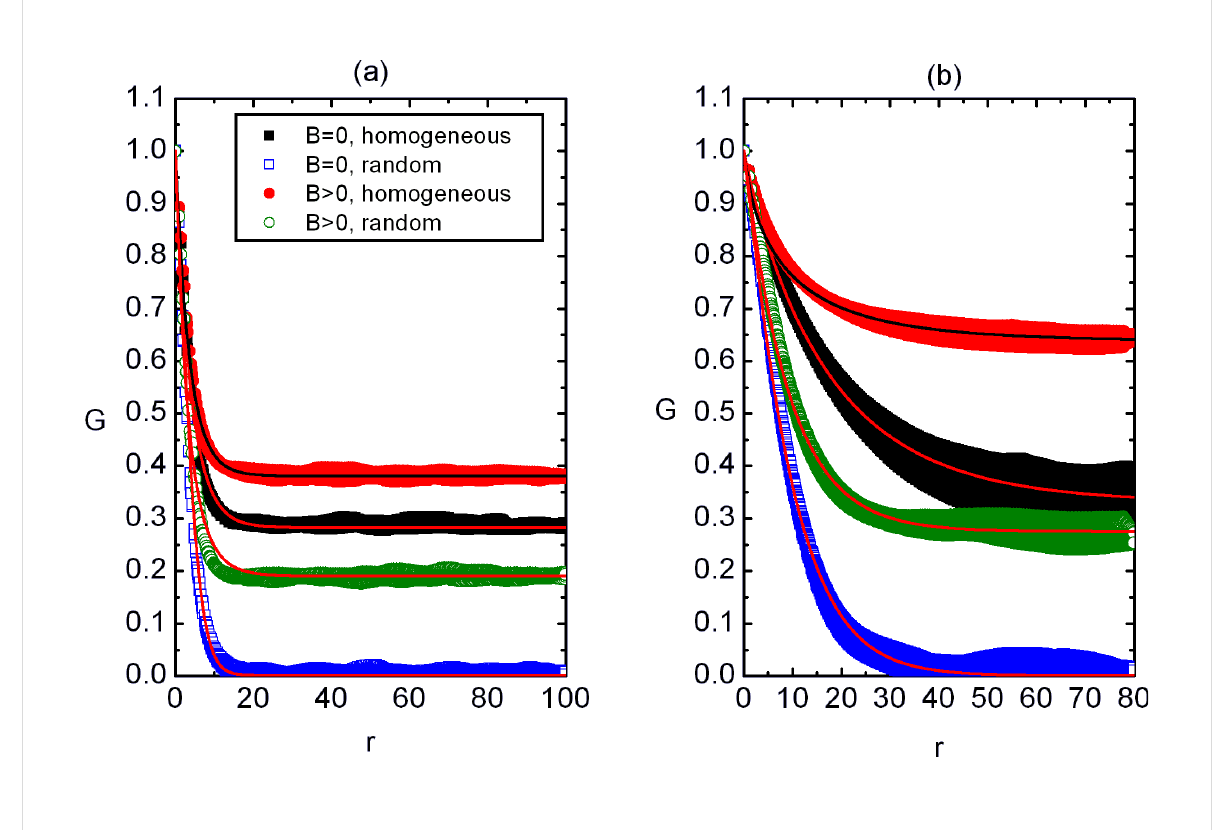
Figure 1: The orientational correlation function as a function of separation r between LC molecules for (a) 2D and (b) 3D systems. In random samples G ( r ) vanishes for large enough values of r for B = 0 while in homogeneous samples it could saturate at a finite plateau s (if p or W are low enough). For B > 0 a finite plateau can be observed also in random samples. (a) p = 0.3, W = 2.5, N 0 = 260; (b) p = 0.3, W = 2.5, N 0 = 100. At r = 1 the first neighbors are placed in the cubic cell. The legend is shown in